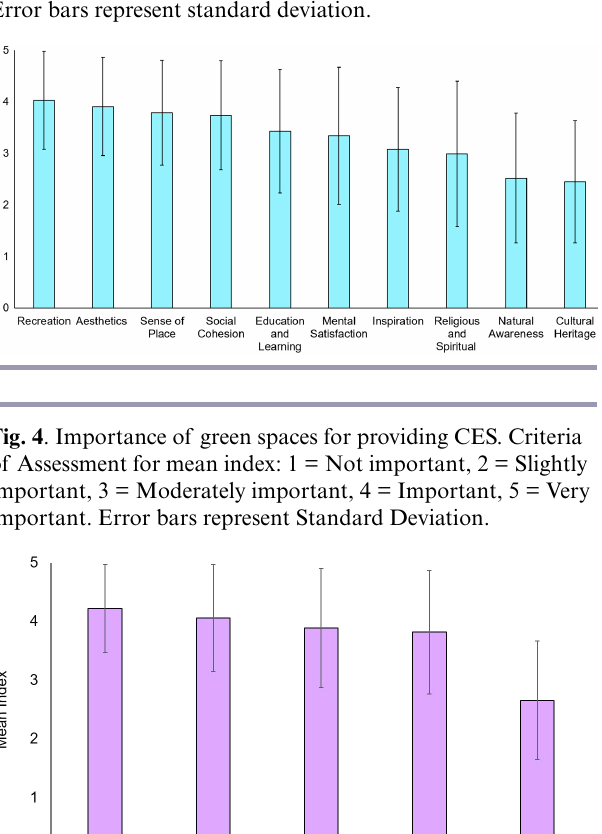
Fig. 3 . Perceived importance of cultural ecosystem services provided by urban green spaces. Criteria of assessment for mean index: 1 = Not important, 2 = Slightly important, 3 = Moderately important, 4 = Important, 5 = Very important.